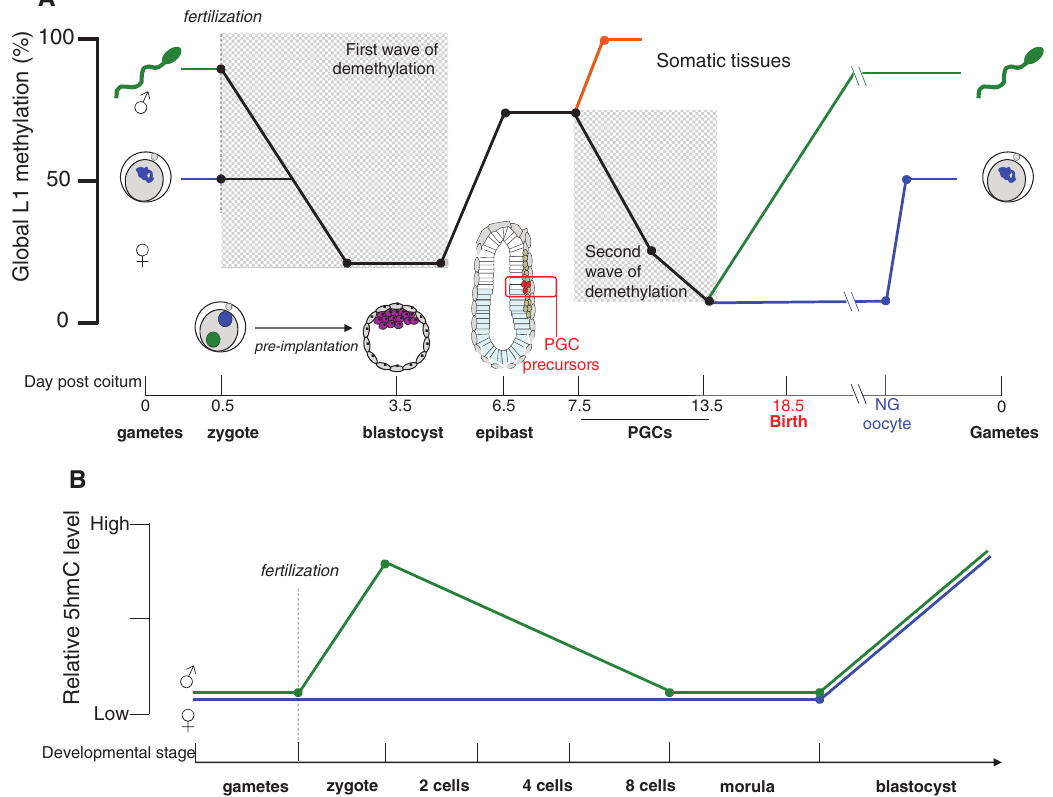
Figure 3 Global L1 methylation and 5hmC level during several steps of mammalian development and associated L1 regulatory mechanisms. (A) Schematic representation of the global L1 methylation level of the mouse genome. During embryonic development, mouse L1 undergoes two main waves of demethylation. The first occurs after fertilization: from the zygote stage (0.5 dpc) until the blastocyst stage (3.5 dpc). The second occurs during the migration of the PGC precursors from the proximal epiblast to the gonad precursors (from 7.5 to 13.5 dpc). PGC, primordial germ cell; NG oocyte, non-growing oocyte. Adapted from ref. (43). (B) Schematic representation of 5-hydromethylcytosine dynamics in paternal and maternal genomes during preimplantation development. Adapted from ref.